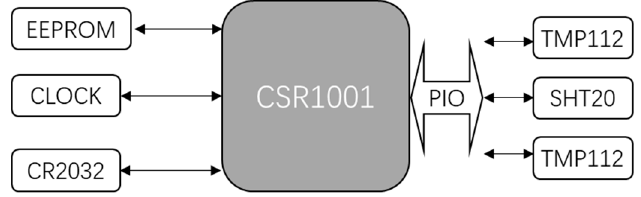
Figure 3. Hardware interface of sensors in smart pillow.